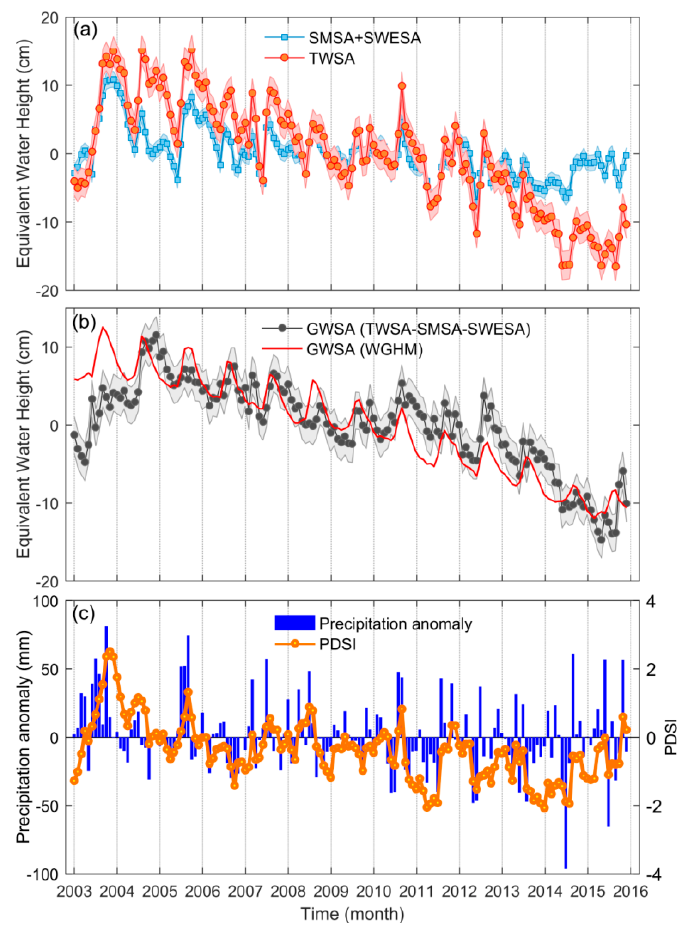
Figure 2. ( a ) Monthly GRACE-based terrestrial water storage anomalies (TWSA) and soil moisture storage anomalies (SMSA) + snow water equivalent storage anomalies (SWESA) derived from GLDAS. The blue and red shaded areas represent the uncertainties in TWSA (2.06 cm) and SMSA + SWESA (1.15 cm); ( b ) monthly GWSA derived from GRACE and WGHM. The shaded area represents the uncertainties in GWSA (2.37 cm); and ( c ) monthly precipitation anomalies and